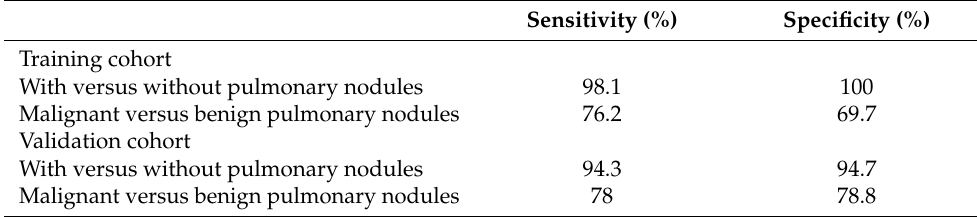
patients with malignant pulmonary